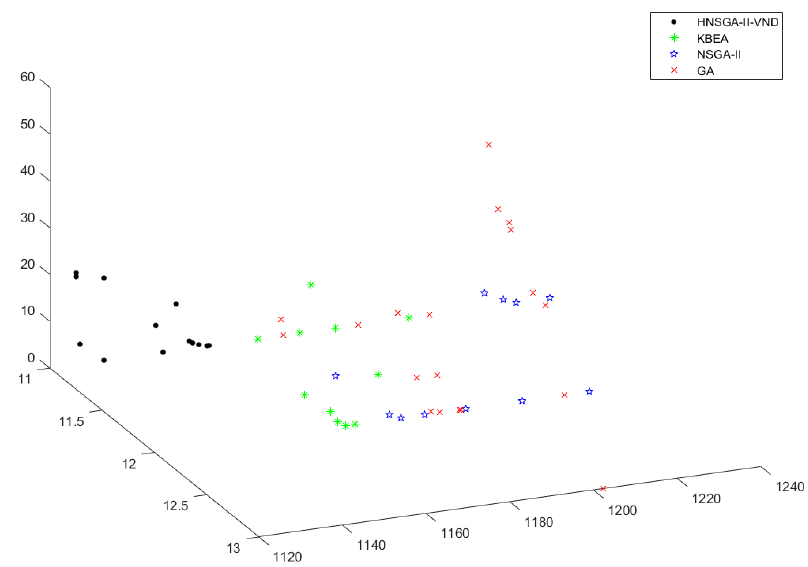
Figure 10. Pareto frontier diagram obtained by all the algorithms on the same instance.